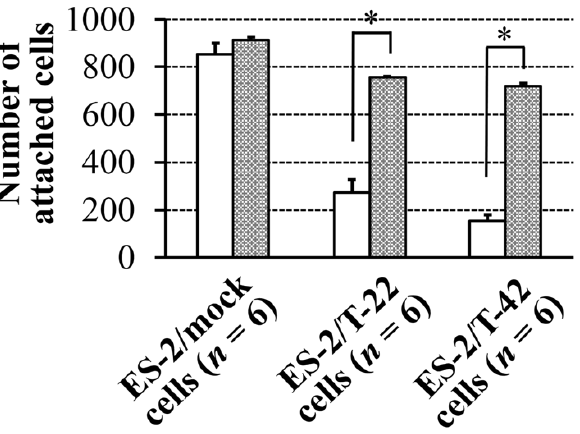
Figure 3. Effect of sialidase treatment of ES-2/mock, ES-2/T-22, and ES-2/T-42 cells on their adhesion to mesothelial cells. Data shown are mean ± SEM. Mann-Whitney U-test. * p < 0.05. The increase after the sialidase treatment was small when ES-2/mock cells were ex- amined, and the difference was not significant. Similar effects of the removal of sialic acid were observed with three other ovarian cancer cell lines, RMG-I, RMG-II, and KK cells (Supplementary Figure S1). These three cell lines exhibit various surface levels of MUC1 with sialyl-T epitope (Supplementary Figure S2). Expression levels of MUC1 with sialyl- T epitope on the cell surfaces of RMG-I, RMG-II, and KK cells seemed to correspond to the degree of the decrease in adhesion.